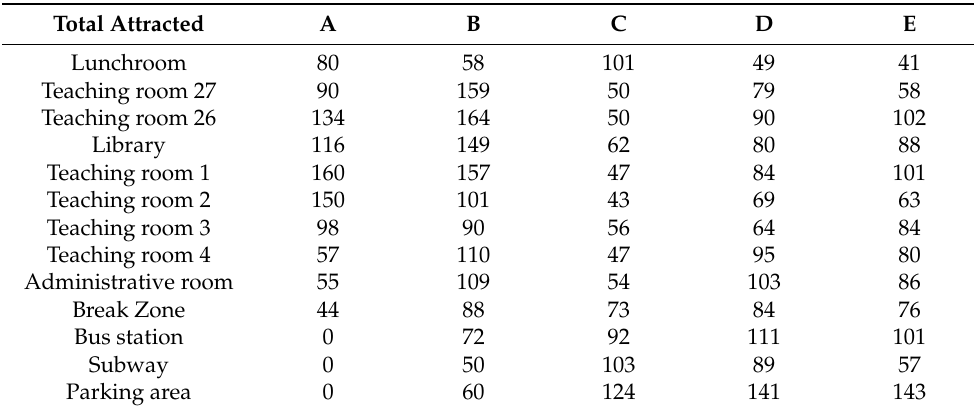
Table 3. Total daily internal path attracted by each time and space interval. Total